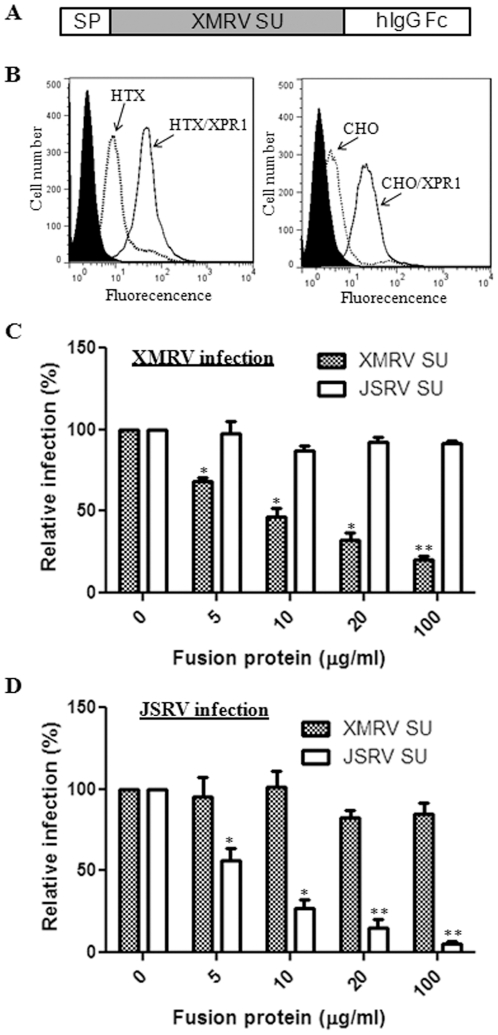
Soluble XMRV SU binds to cells expressing the viral entry receptor, XPR1, and blocks XMRV pseudovirion infection.(A) Schematic representation of XMRV SU-human immunoglobulin (hIgG) Fc fusion protein. SP: signal peptide. (B) Indicated cell lines were incubated with 5 µg of XMRV SU-hIgG Fc for 4 h and binding was measured using anti-human IgG FITC and flow cytometry. Filled: HTX or CHO cells stained with a FITC-labeled secondary antibody only (HTX/XPR1 or CHO/XPR1 cells gave a similar background signal which was not overlaid); broken line: parental HTX or CHO cells stained with XMRV SU plus secondary antibody; black line: HTX/XPR1 or CHO/XPR1 cells stained with both XMRV SU and secondary antibody. Representative experiments are shown (n = 5). (C, D) HTX cells were pre-bound with indicated amounts of soluble XMRV or JSRV SU for 1 h at 4°C and infected with MoMLV pseudotypes encoding alkaline phosphatase (AP) and bearing XMRV Env (C) or JSRV Env (D) for 6 h before inactivation of remaining virions using citrate buffer. AP foci were counted 72 h post-infection and values were normalized to infection in the absence of soluble protein set to 100%. Shown are the averages of 3 independent experiments ± S.D. * indicates p<0.05; ** indicates p<0.01.